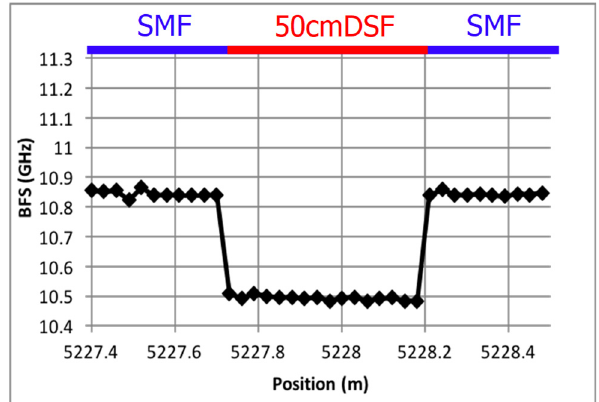
Figure 37. BFS distribution measured by the BOCDR system having the four performance improvement schemes [86]. The measurement range and the spatial resolution is 3.94 cm and 5280 m, respectively. The ratio between these is